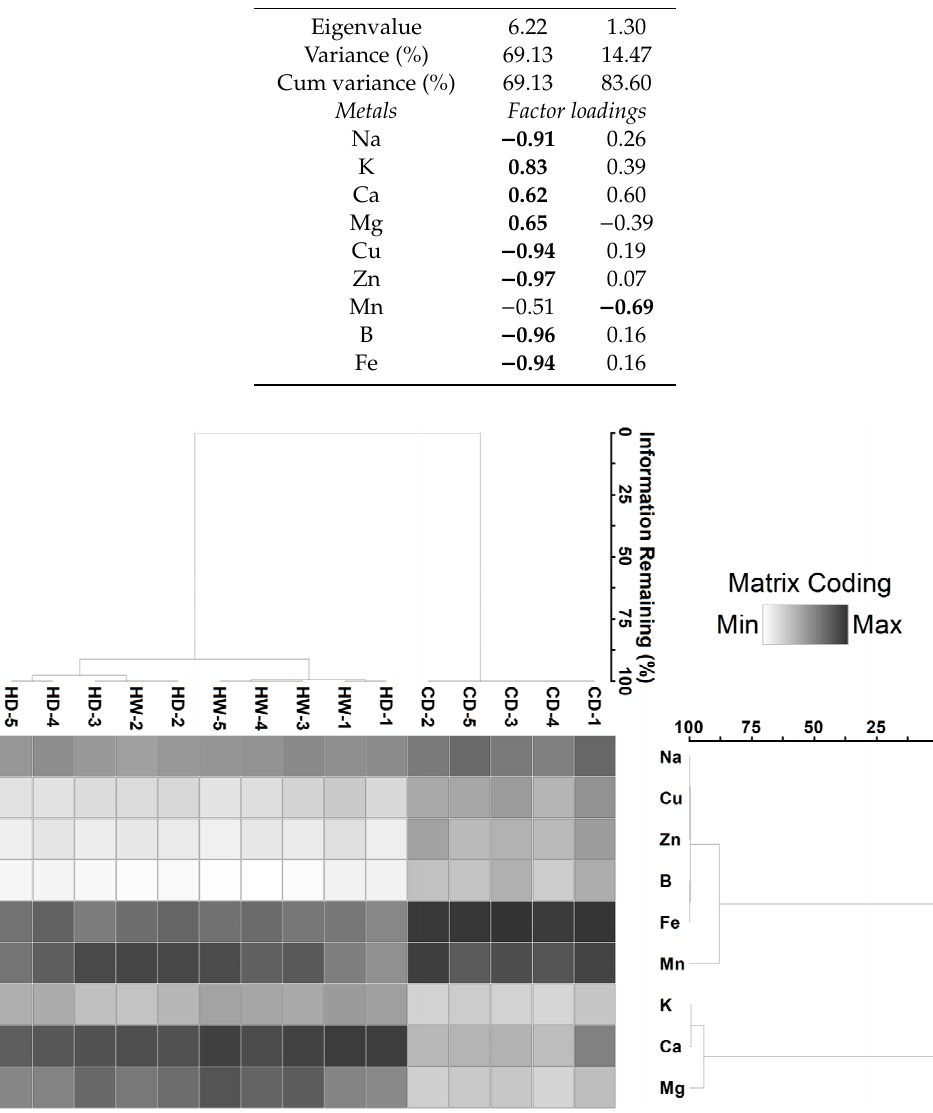
Figure 2. Two-way cluster analysis for sediment chemistry variables across the 5 study sites (i.e., M1–M5) and three seasons (i.e., cool-dry (CD), hot-dry (HD), hot-wet (HW)) from the Mvudi River system, South Africa.